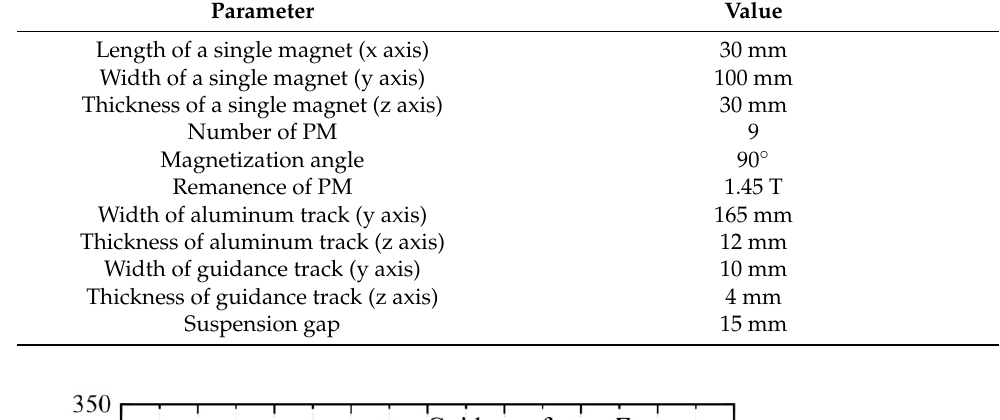
Figure 6. The finite element model of the guidance system.